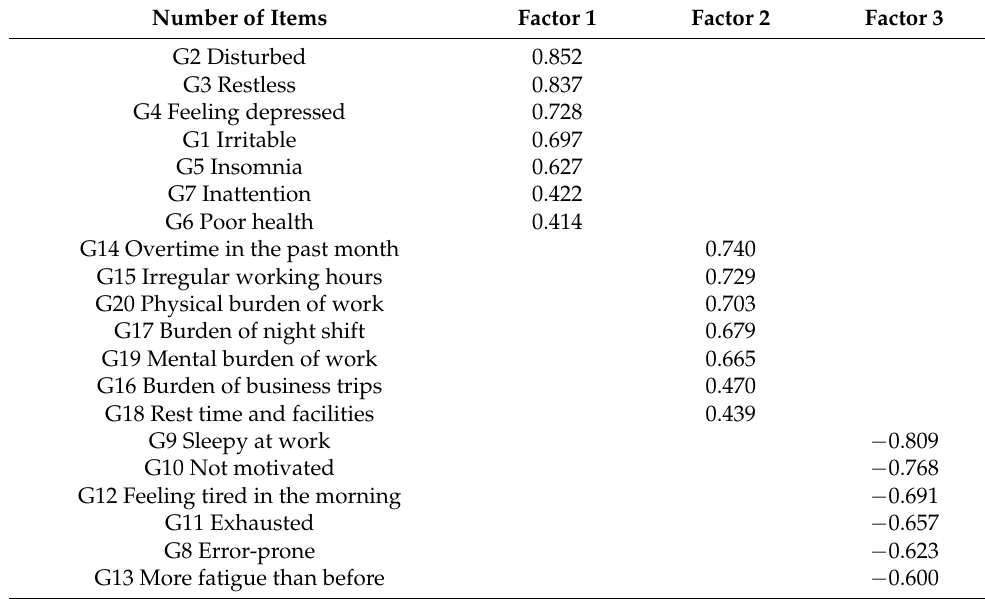
Table 3. The Self-Diagnosis Scale of Workers’ Cumulative Fatigue with factor load